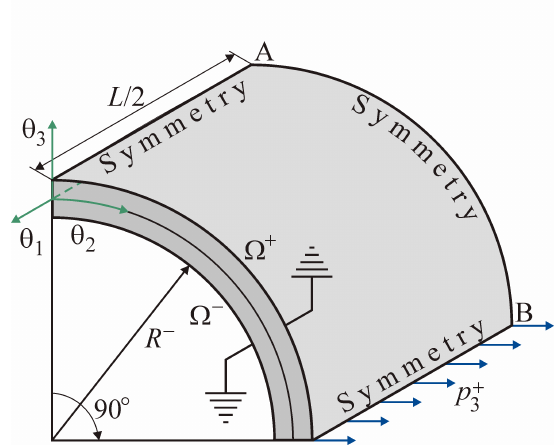
Figure 11: FGM piezoelectric cylindrical